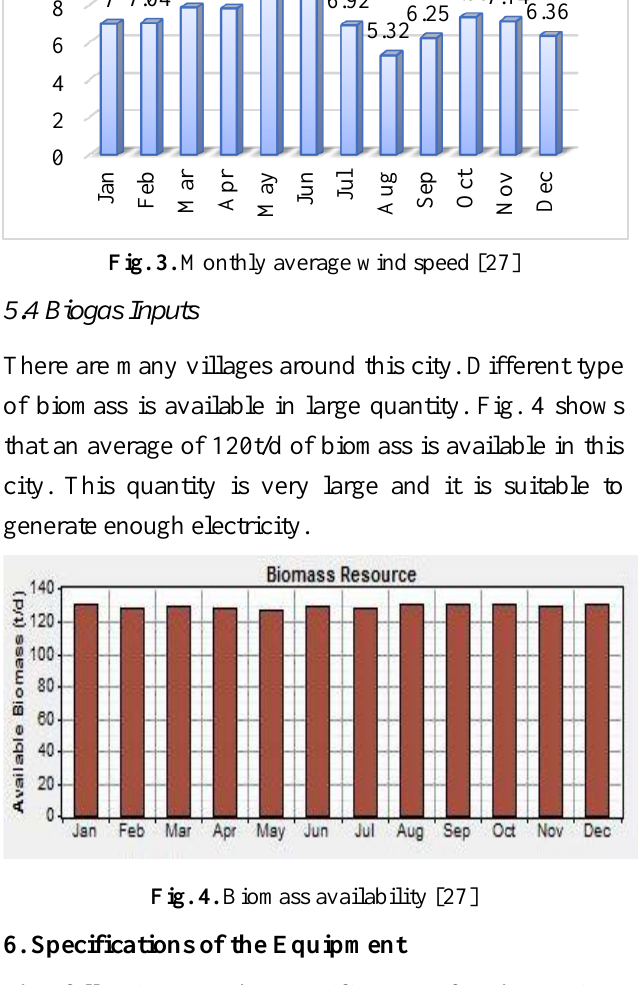
Fig. 5. Simulink model of proposed charging station